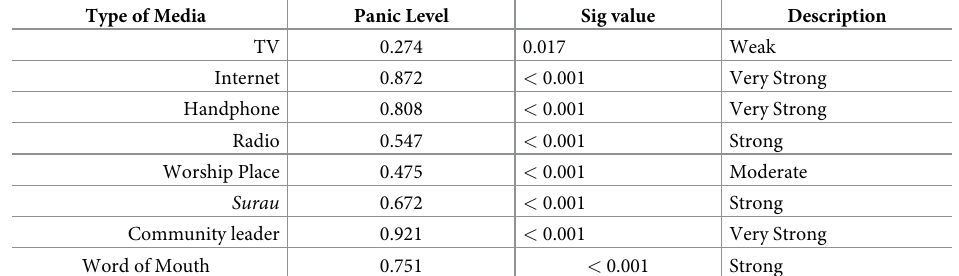
Table 5. The relationship between types of disaster information source media and panic level of affected commu- nity in Palu Regency.